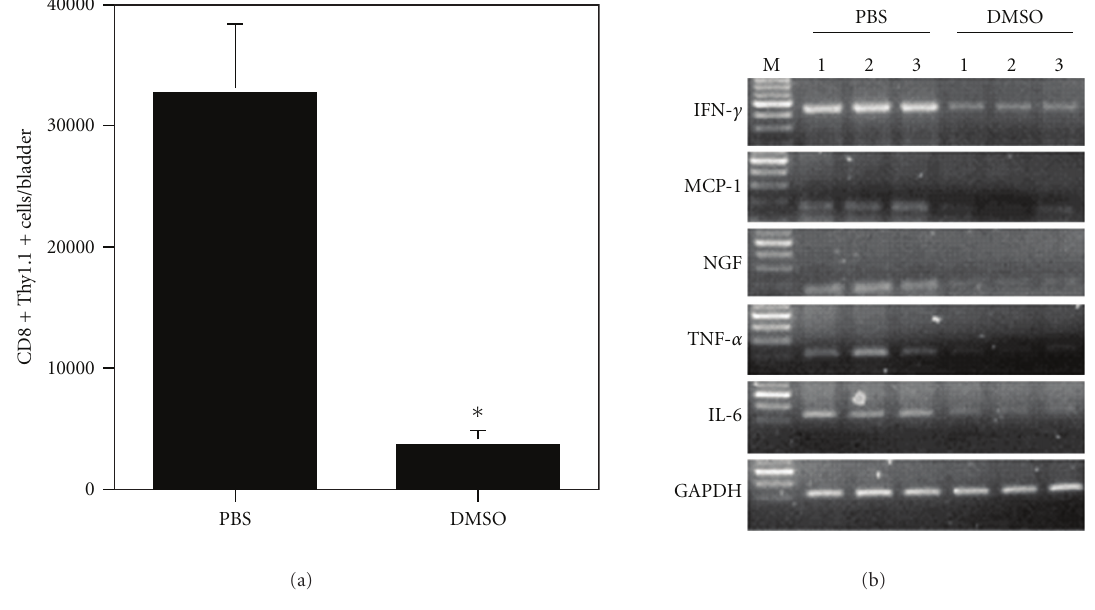
Figure 3: Intravesical DMSO treatment reduces infiltrating e ff ector CD8 + T cells and bladder expression of inflammatory factor mRNAs in acute autoimmune cystitis. (a) The DMSO-treated bladders show reduced infiltrating e ff ector CD8 + T cells. Bladder single-cell suspensions were prepared, stained with anti-Thy1.1 and anti-CD8 antibodies, and analyzed by flow cytometry. Gate was set on lymphocytes according to scatter criteria. The number of double positive T cells per bladder is presented as mean ± standard deviation of 5 bladders. ∗ P < . 001 (compared to the PBS-treated bladders). (b) The DMSO-treated bladders show reduced production of IFN- γ , MCP-1, NGF, TNF- α , and IL-6 mRNAs. Bladder total RNAs were extracted and analyzed by RT-PCR for the indicated inflammatory factors. GAPDH was used as an internal control. Three bladders for each of PBS- and DMSO-treated groups are presented. The results are representative of two separate experiments consisting of 4-5 animals per group. M: 100bp